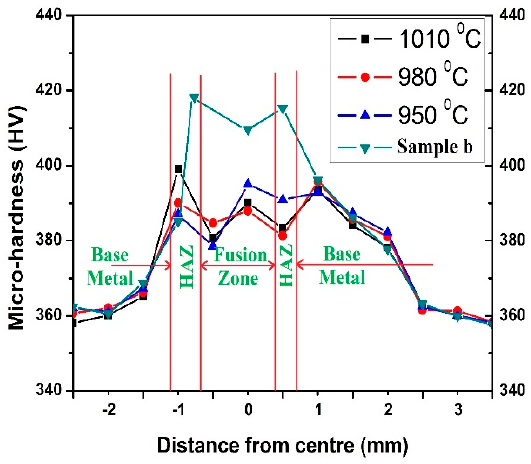
Figure 13. Microhardness of welded joints at different annealed temperatures.